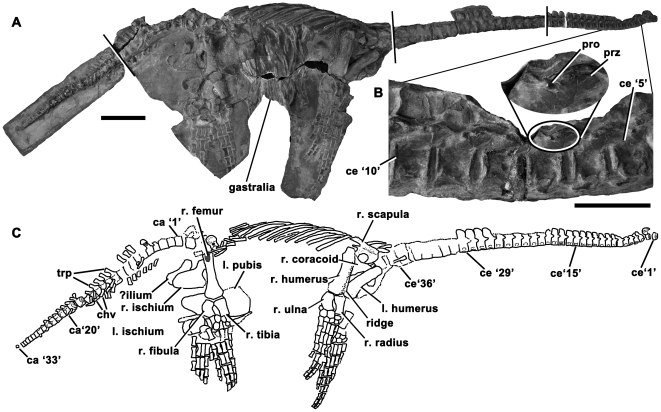
Holotype of Eoplesiosaurus antiquior (TTNCM 8348) in right lateral view.Image in A is a composite made from four photographs (divisions are indicated by black and white lines), with enlargement of anterior cervical vertebrae (B; magnified portion is enlarged x2.0 times). Gastralia are not shown in line drawing (C). Abbreviations: ca, caudal vertebra; ce, cervical vertebra [number following indicates order in preserved series]; chv, chevron; l., left [followed by name of element]; pro, lateral projection; prz, prezygapophysis; r., right [followed by name of element]; trp, transverse process. Scale bars equal 200 mm (A, C) and 50 mm (B).